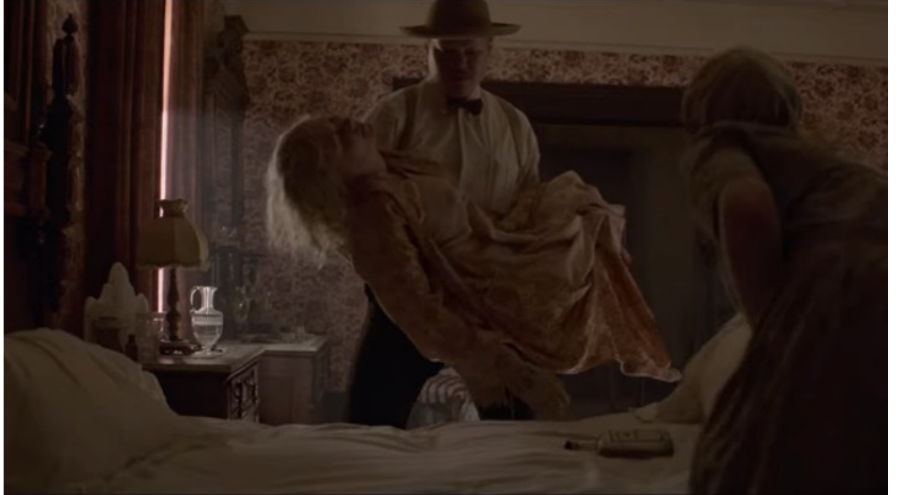
Figure 14. The Power of the Dog . Netflix.